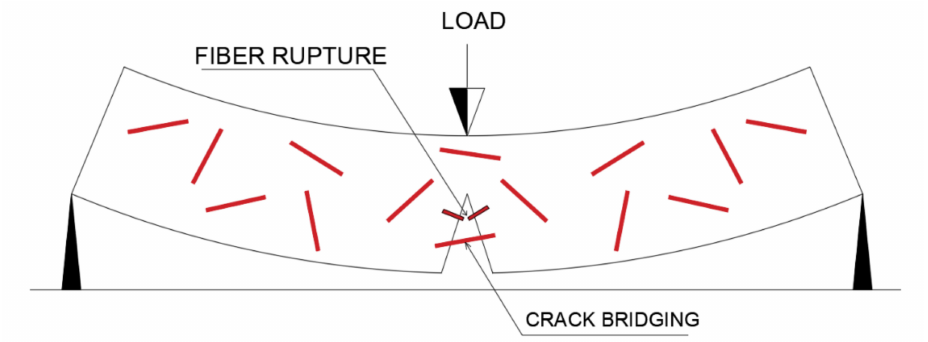
Figure 5. Fiber organization scheme in a